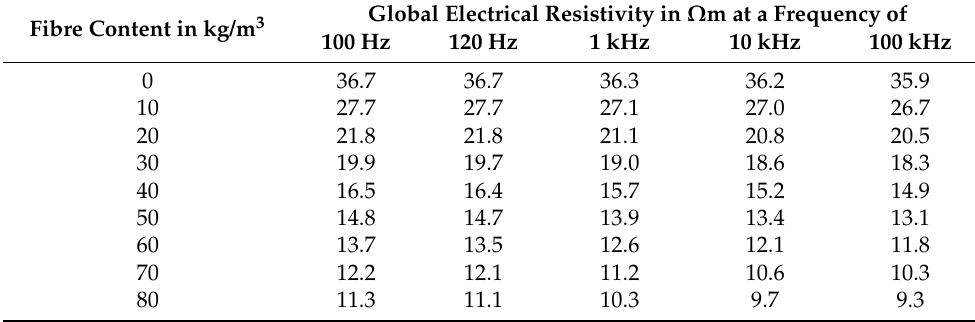
Table A14. Results of the resistivity measurements of the concrete mixture 32-60-330-00.